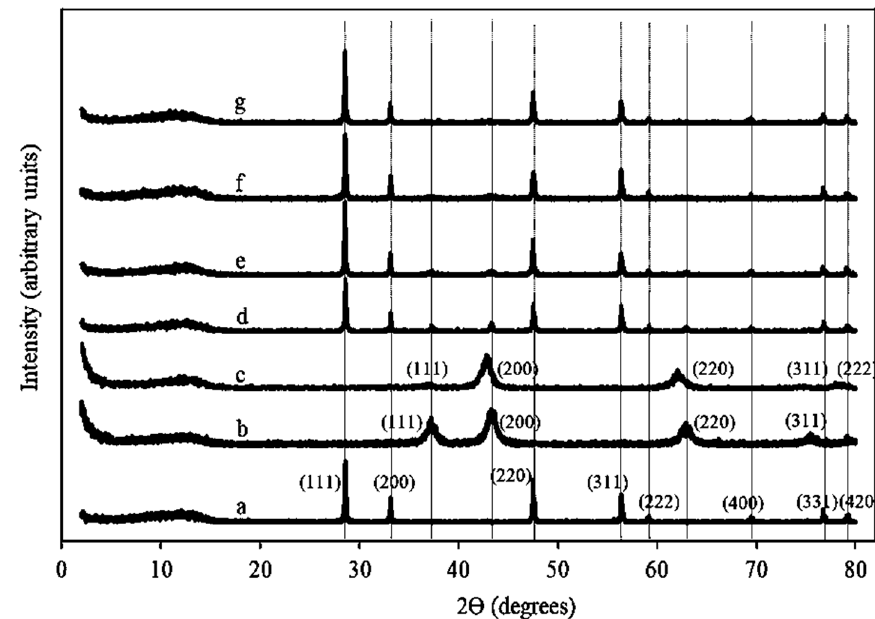
Figure 1. XRD patterns of ( a ) CeO 2 , ( b ) NiO, ( c ) MgO, ( d ) Ni/Ce–Mg prepared by IM and calcined